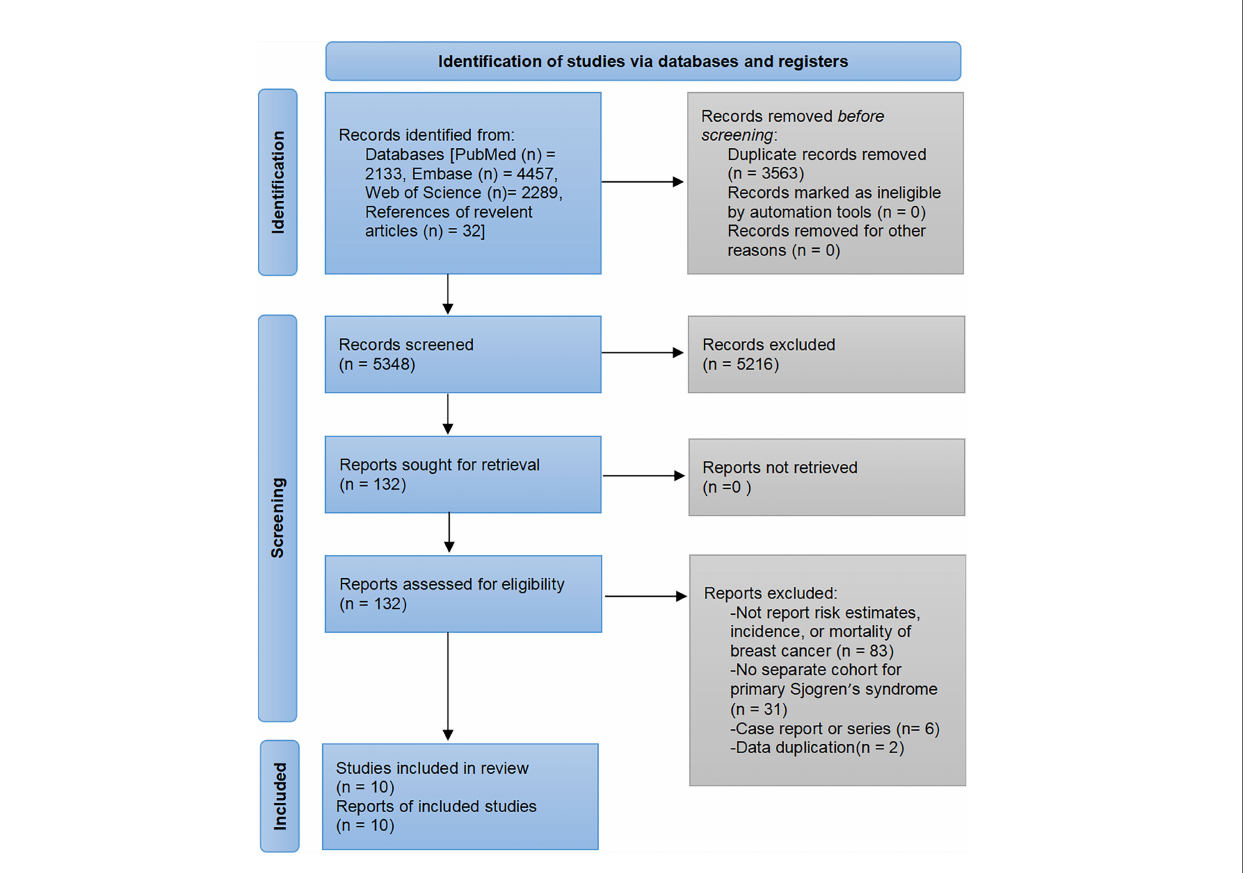
FIGURE 1 | Flow diagram of the study selection